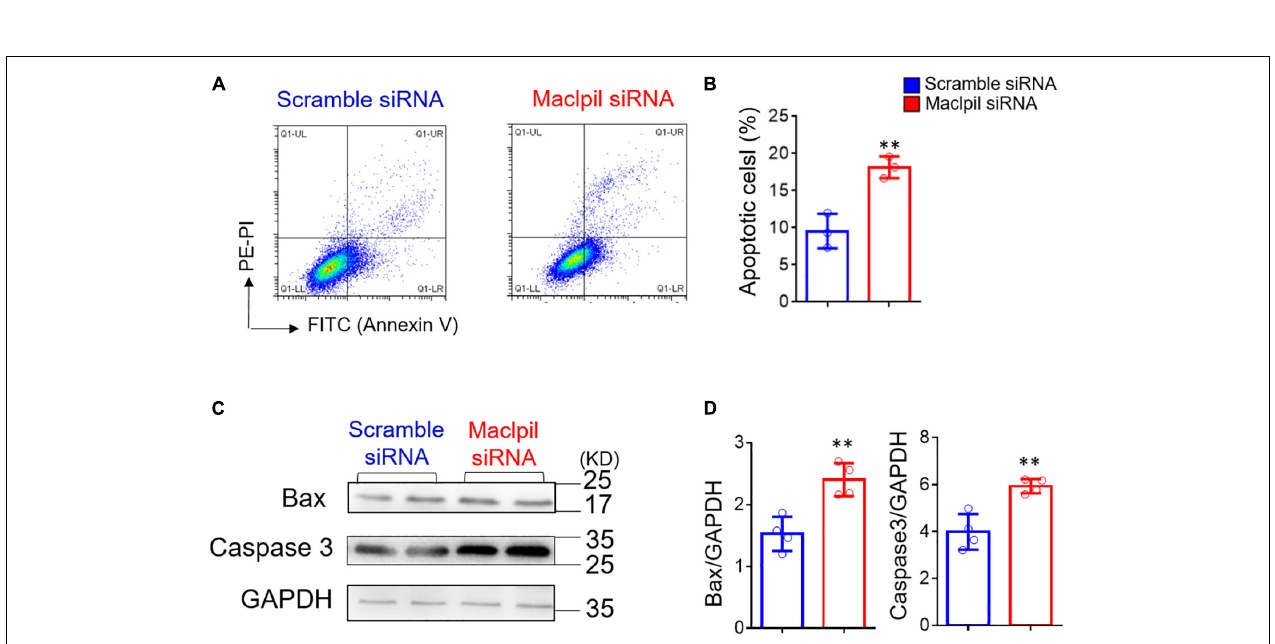
FIGURE 5 | siRNA silencing Maclpil increases apoptosis and proapoptotic protein expression in macrophages undergoing oxygen glucose deprivation treatment. (A) Representative flow cytometric pseudocolor plots showing Annexin + PI + apoptotic cells in Maclpil or scramble siRNA-treated bone marrow-derived macrophages (BMDCs). (B) Quantification of apoptotic cells in Maclpil and scramble siRNA-treated BMDCs. (C) Representative Western blots for proapoptotic proteins (Bax and caspase 3) and house-keeping gene (GAPDH) in Maclpil- and scramble siRNA-treated BMDCs. (D) Quantification of the expression of Bax